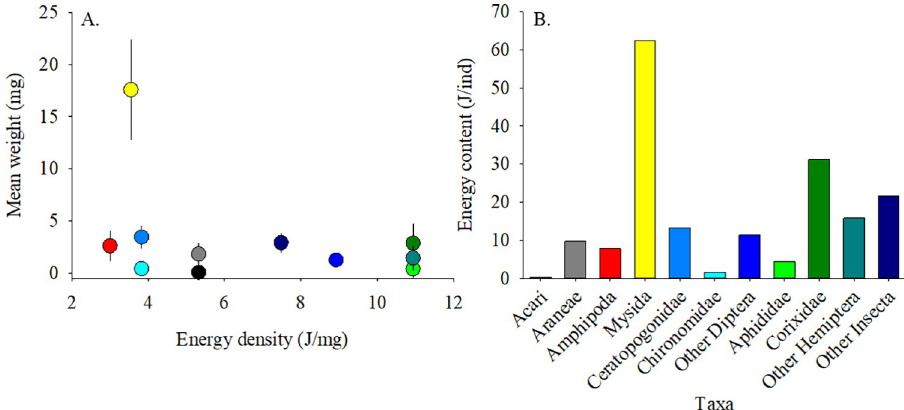
Fig 4. Variation in energy attributes of prey taxa. A. Weight and energy density. Error bars are standard errors. B. Energy content by taxa. Color codes in Fig 4A correspond to the taxa designations in Fig